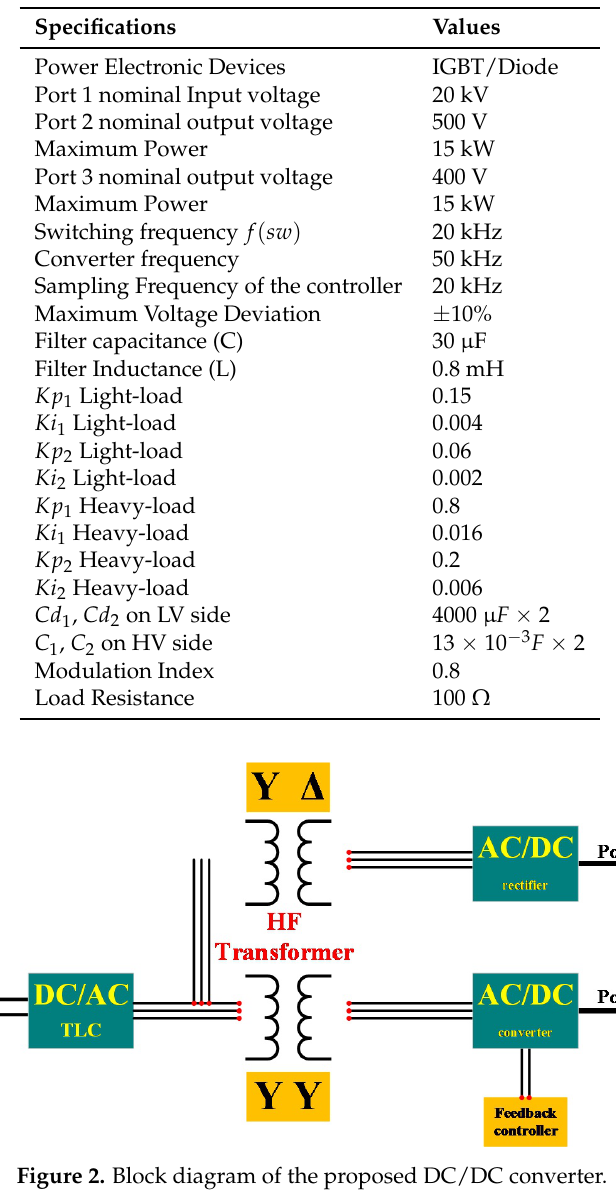
Figure 2. Block diagram of the proposed DC/DC